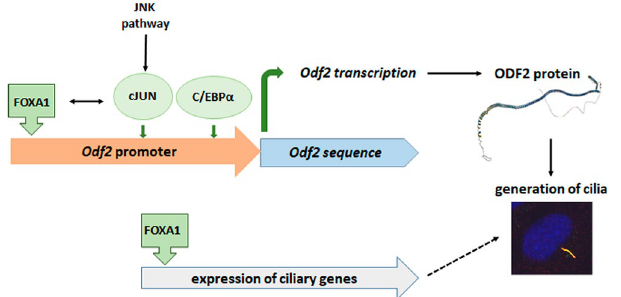
Figure 10. FOXA1 is a transcriptional activator of Odf2, which ultimately promotes cilia formation. FOXA1 binds to the sequence TGT TTA C at positions − 1768 to − 1775 of the Odf2 promoter and promotes transcription of Odf2 . The JNK-pathway via cJUN, and C/EBPα are also involved in the transcriptional activation of Odf2 , although their binding sites have not been determined. Positive feedback was found between cJUN and FOXA1 in the transcriptional activation of the Odf2 promoter, although a direct interaction could not be detected. According to the ChIP-seq dataset from the ENCODE Transcription Factor Targets Datasets, FOXA1 targets many more essential ciliary genes, including CP110 , which we have shown is indeed regulated by FOXA1. The finally generated ODF2 protein, which is mandatory for the generation of primary cilia, eventually promotes cilia formation together with other ciliary proteins. The structure of the ODF2 protein ( Mus musculus) was predicted by AlphaFold (AlphaFold DB version 2022-11-01, created with the AlphaFold Monomer v2.0 pipeline, licence CC-BY-4.0), and made available by EMBL-EBI (Wellcome Genome Campus, Hinxton, UK). The primary cilium was detected by immunological decoration of both, acetylated α-Tubulin (green) and ARL13B (red), shown here as merged image (yellow), and the nucleus stained with DAPI (blue)